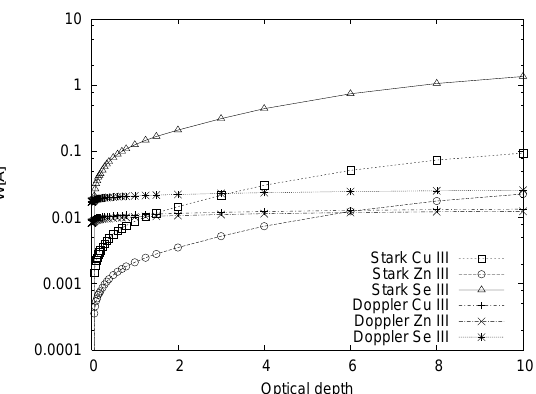
Fig. 3. Thermal Doppler and Stark widths for CuIII 4s 2 F { 4p 2 G o ( (cid:21) = 1774.4 (cid:23)A), ZnIII 4s 3 D { 4p 3 P o ( (cid:21) = 1667.9 (cid:23)A) and SeIII 4p5s 3 P o { 5p 3 D ( (cid:21) = 3815.5 (cid:23)A) spectral lines for a model of the DB white dwarf atmosphere with T eff = 15000 K and log g = 7, as a function of the optical depth (cid:28) 5150